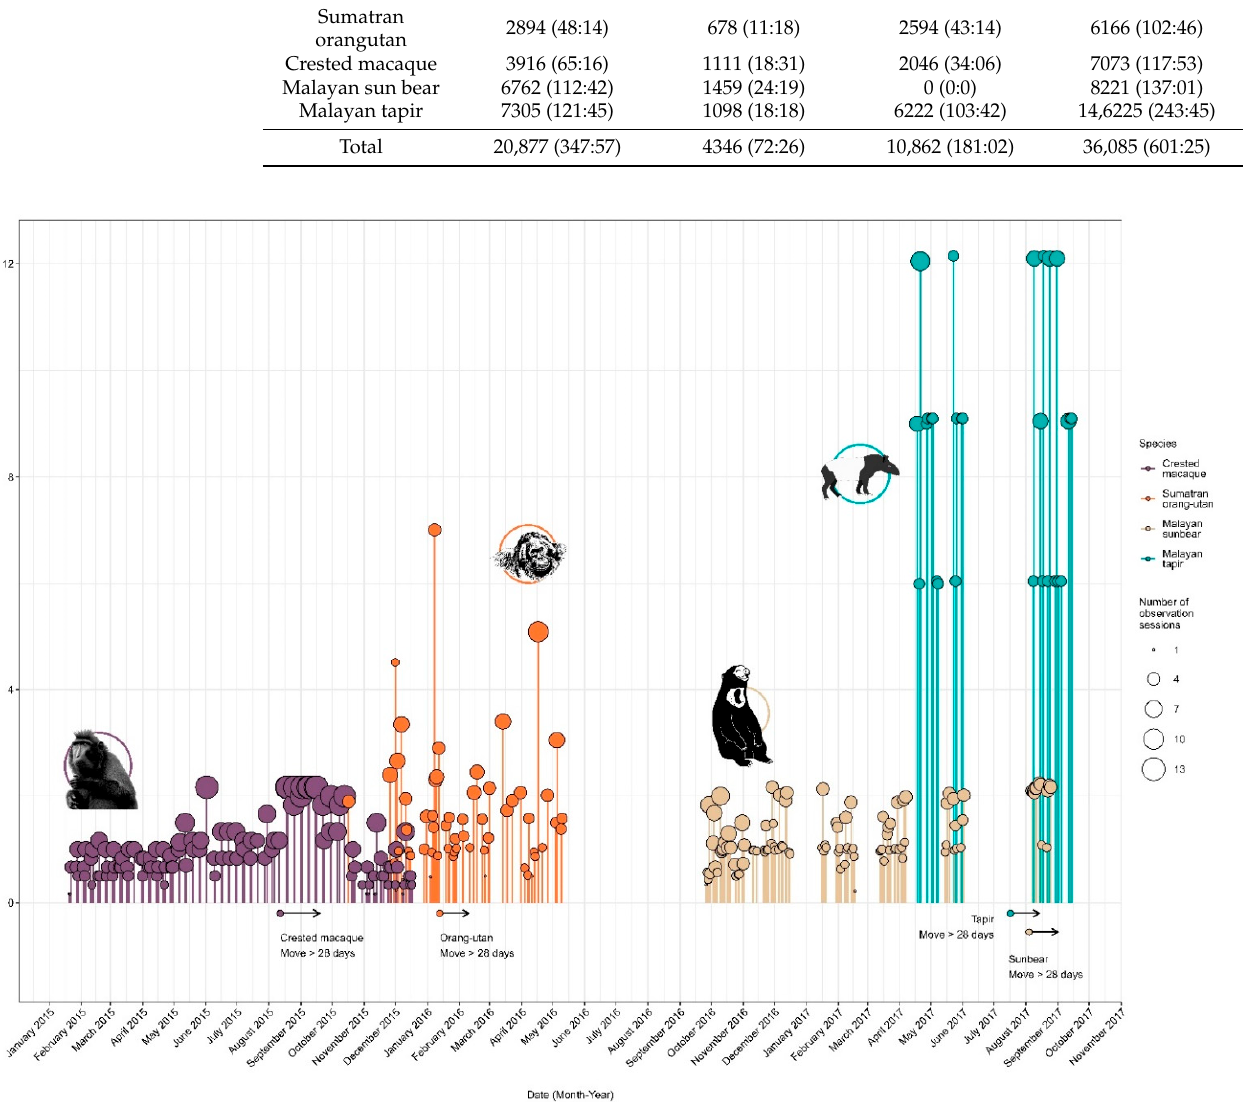
Figure 1. Data collection timeline and summary for four Islands project species: Sumatran orangutan ( Pongo abelii ), crested macaque ( Macaca nigra ), Malayan sun bear ( Heloarctos malayanus ) and Malayan tapir ( Tapirus indicus ) at Chester Zoo, U.K. Stems and points indicate the number of hours of observation data and number of observation sessions per day, respectively. Arrows (reading from left to right) indicate the date of relocations to the new Islands exhibit from within the core zoo and subsequent 28 days (Early-Post). Data stems and points prior to the arrow signifies Pre-Move period and stems and points beyond the arrow signifies Post-Move periods.